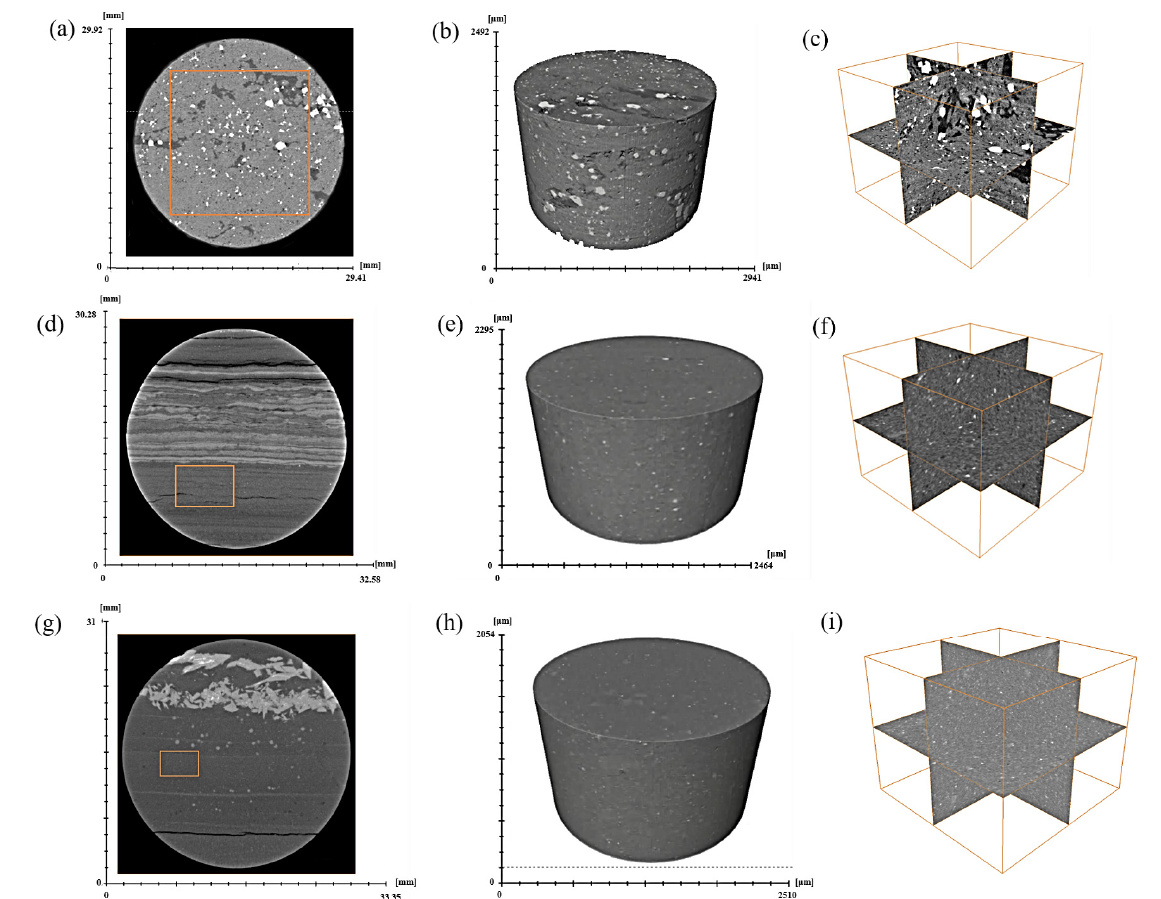
Figure 6. Micron CT scan of sample A ( a – c ), B ( d – f ) and C ( g – i ).